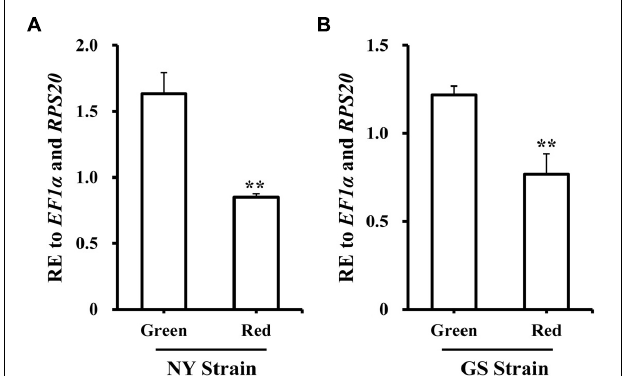
FIGURE 2 | Expression profiles of GGPPS in green and red morphs of the NY and GS strains of Acyrthosiphon pisum . (A) Expression patterns of GGPPS in red and green morphs of NY strain. (B) Expression patterns of GGPPS in red and green morphs of GS strain. A significant difference between red and green morphs is indicated by asterisks ( ∗∗ P <